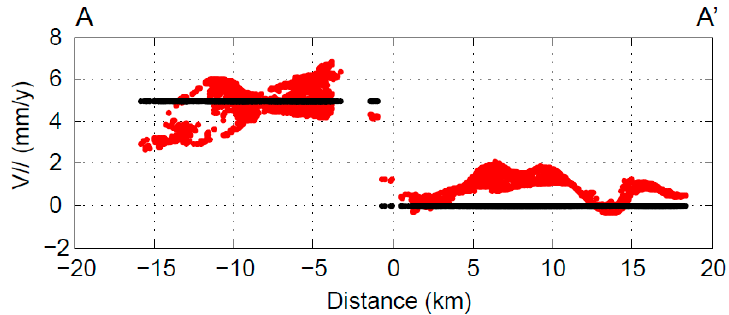
Figure A5. Input (black dot) and recovered (red dot) horizontal velocity (N30°W) on profiles perpendicular to the orientation of the fault (Figure A4a,i). Similar to Figure A3, but using the spatially-correlated noise instead of the Gaussian noise in the synthetic test.